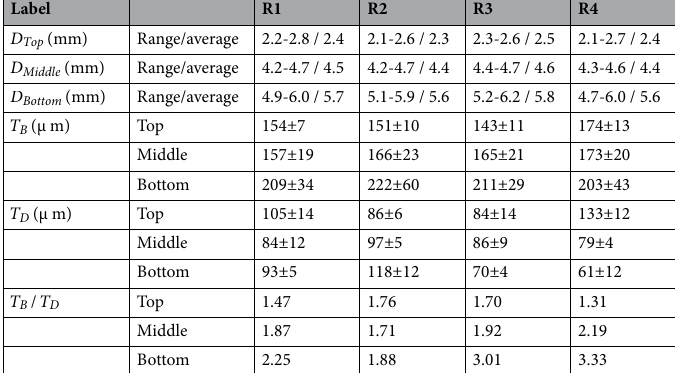
Table 3. Diameter of the top (D Top ), middle (D Middle ) and bottom (D Bottom ) of the fresh culm. The thickness of the bulge region (T B ) and thickness of the depressed region (T D ) of the dried culm wall measured by a metallographic microscope. The symbol ± in table refers to the distribution range of data.